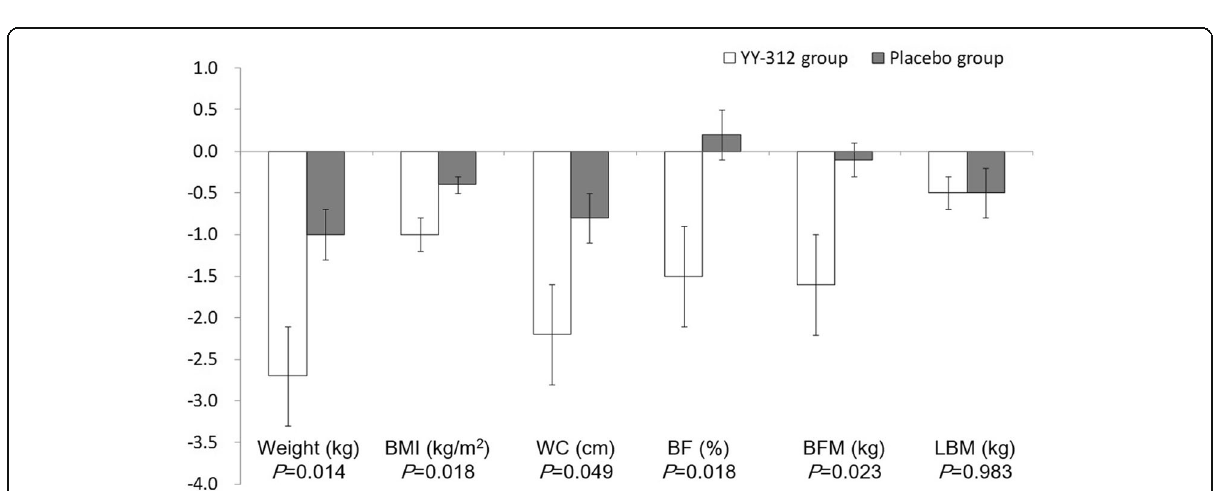
Fig. 2 Mean changes in anthropometric and body composition variables after 12 weeks. Negative values correspond to decreases from baseline. Positive values correspond to increases from baseline. Error bars indicate SE. BMI: body mass index, WC: waist circumference, BF: body fat, BFM: body fat mass, LBM: lean body mass, SE: standard